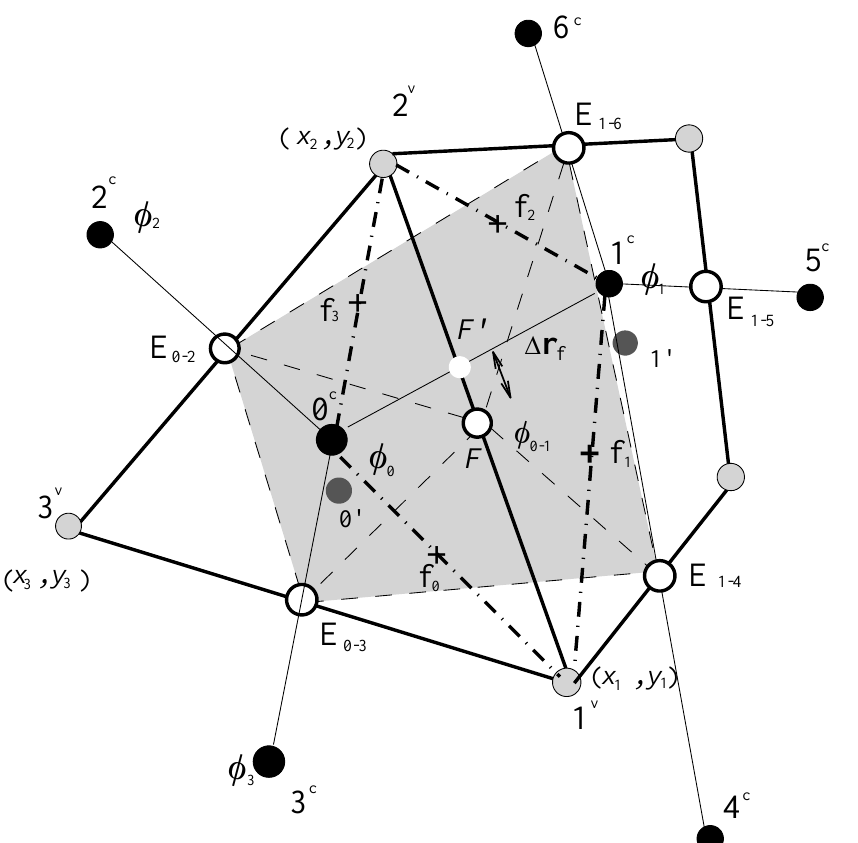
Figure 1. Typical triangle and quadrilateral cells: the black circle denotes the cell centers; the gray